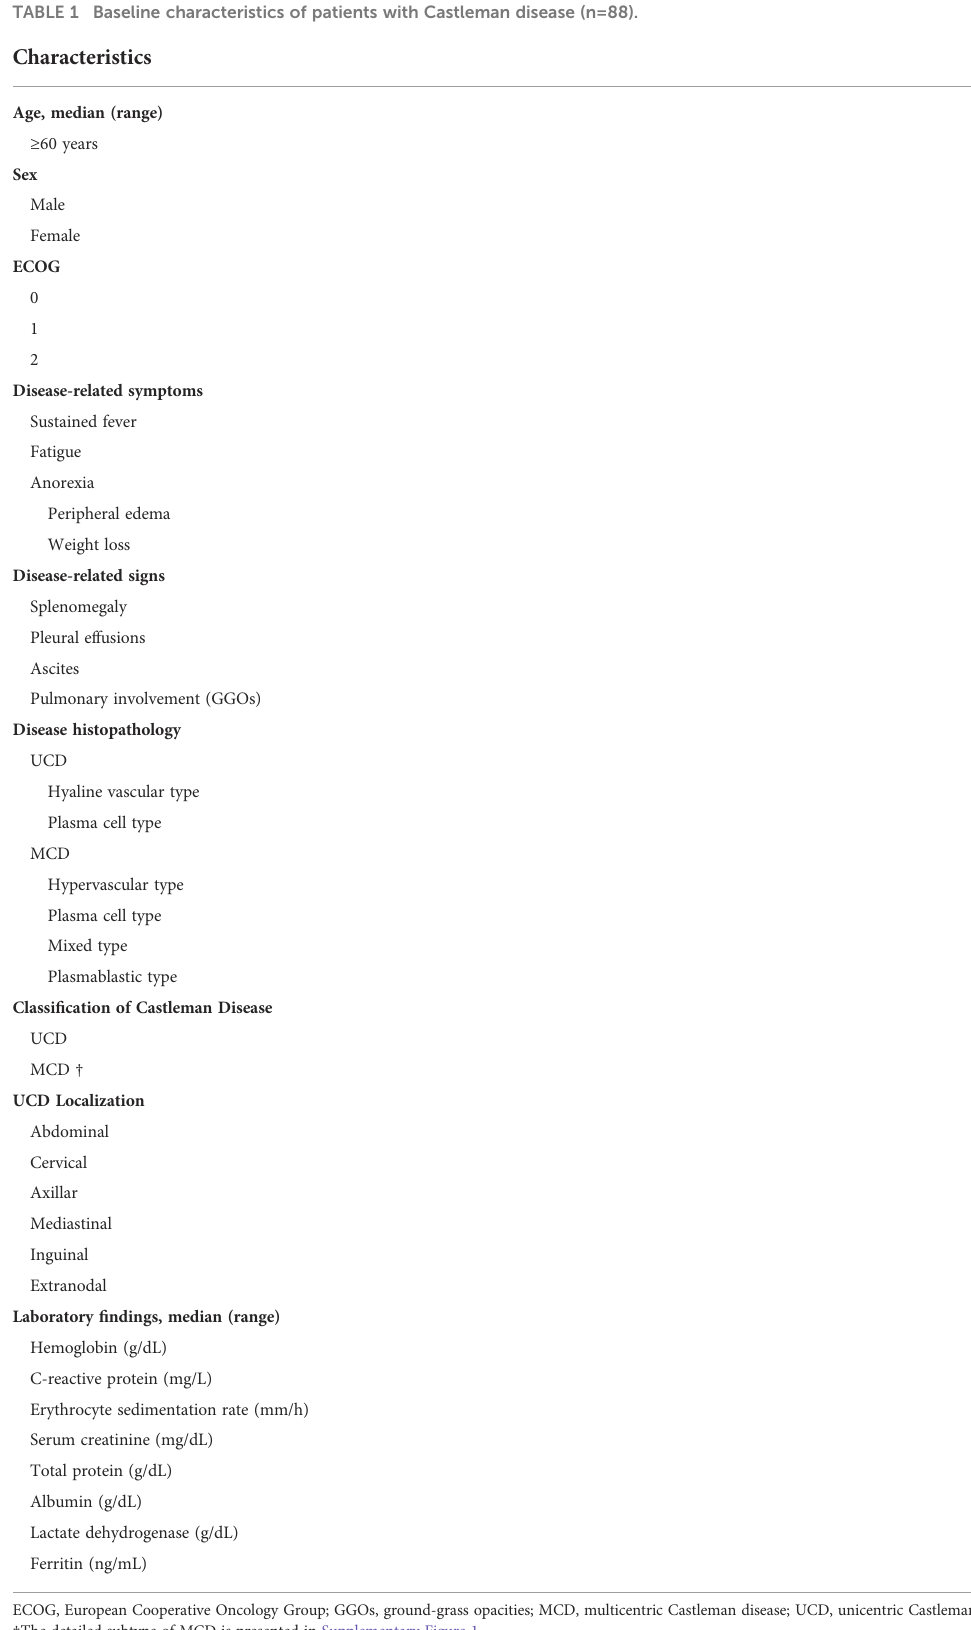
TABLE 1 Baseline characteristics of patients with Castleman disease